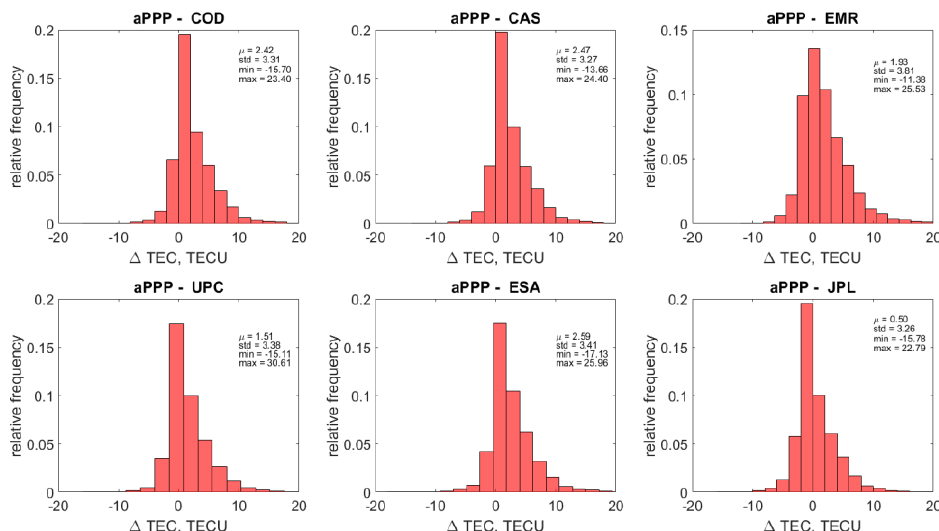
Figure 15. Distribution of the differences between Vertical TEC values retrieved using the ionosphere retrieval equation (labeled as aPPP) and GIM VTEC values from six different Ionosphere Associate Analysis Centers (IAAC) for GPS.